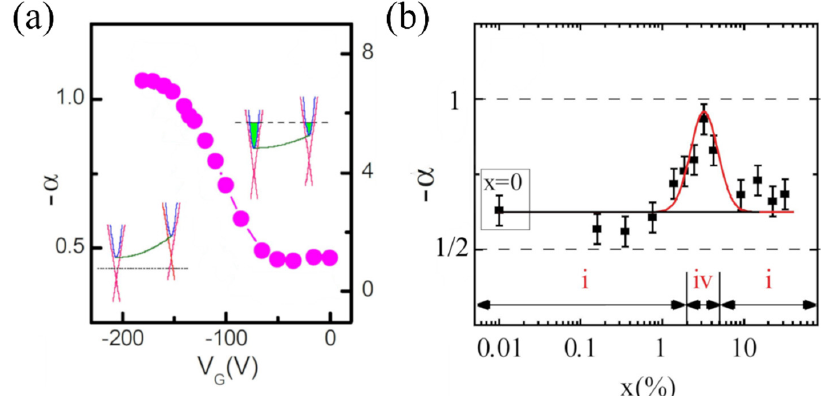
Figure 8. Modulation of α : ( a ) effect of negative gating voltage V G on α . The insets on the left and right are band diagrams showing the Fermi level modulation relative to the bands. ( b ) Effect of Cu doping (x represent the Cu content) on α . The numbers i and ii correspond to the coupled and decoupled case, respectively. Reprinted with permission from references [32,40]. Copyright 2011 and 2014 American Physical